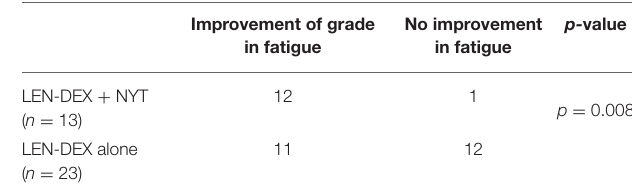
TABLE 2 | Frequency of reduced grade of fatigue during treatment.